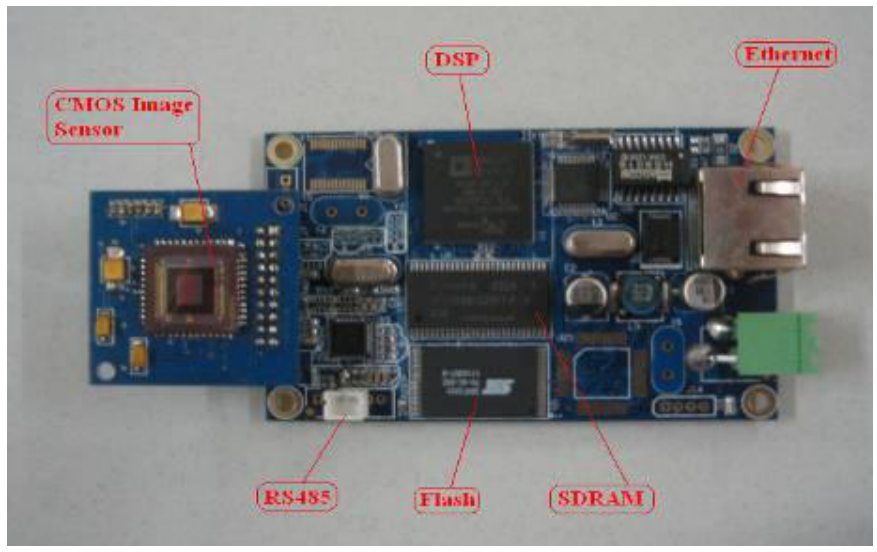
Figure 4. Hardware circuit board of smart visual sensor.